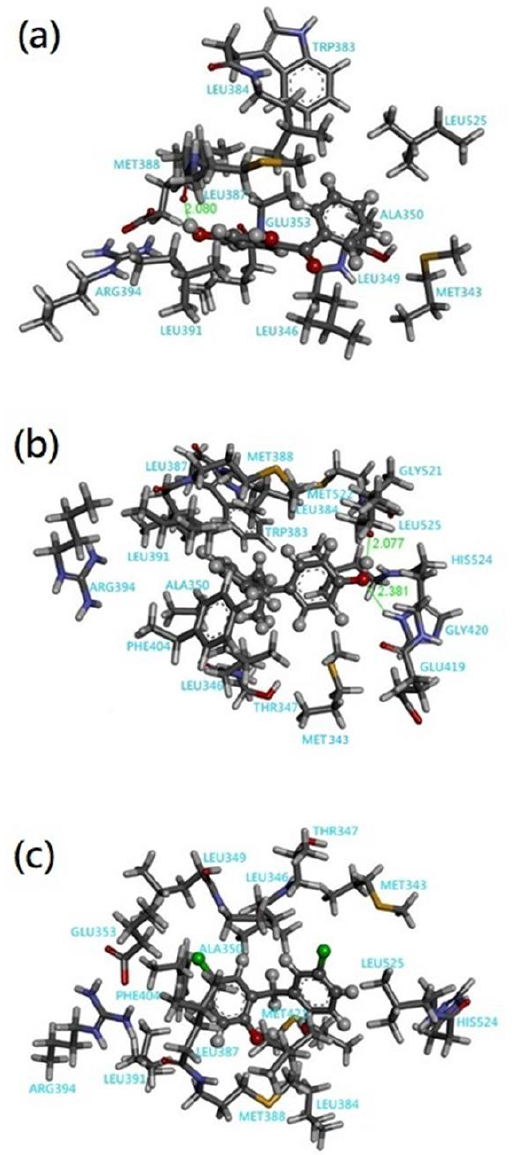
Figure 4. The quantum chemical cluster models for the ERα receptor (PDB 3ERT) with DDT s: (a) 2,4-Dihydroxybenzophenone, (b) p-Cumylphenol, and (c) 2,2'-Methylenebis(4-chlorophenol).